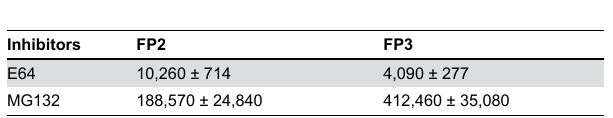
Table 3. Association rate constants (M -1 . S - 1 ) for recombinant falcipains a